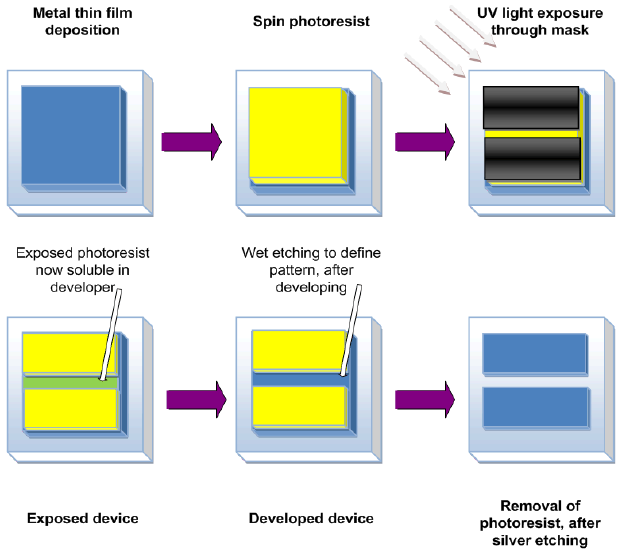
Figure 1. Photolithography procedure to define pair of rectangular electrodes on glass substrate.